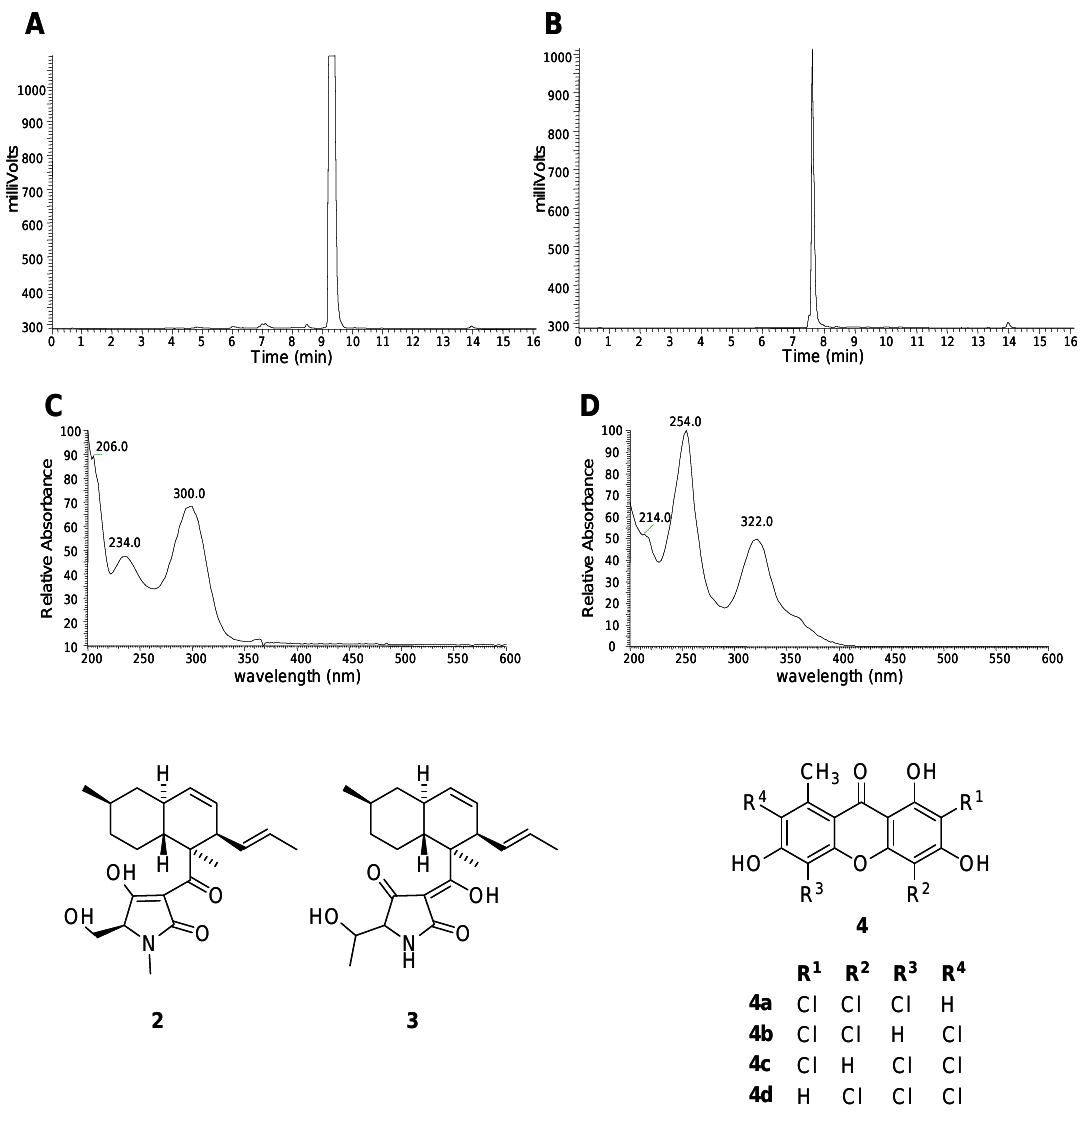
Figure 8. Analytical data for select samples containing one major component. A) HPLC- ELSD chromatogram of 70254-F08. B) HPLC-ELSD chromatogram of 70360-F09. C)